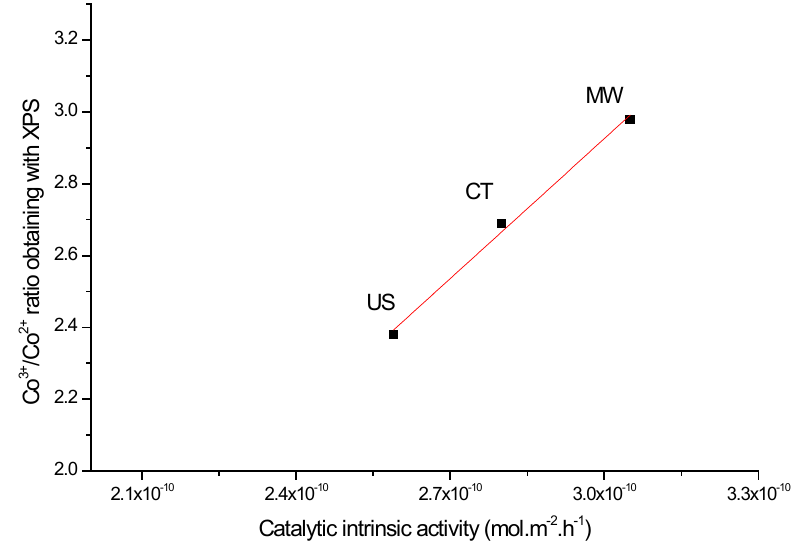
Figure 6. Relationship between catalytic intrinsic activity and H 2 consumption during the H 2 -TPR corresponding at Co 3 O 4 species.